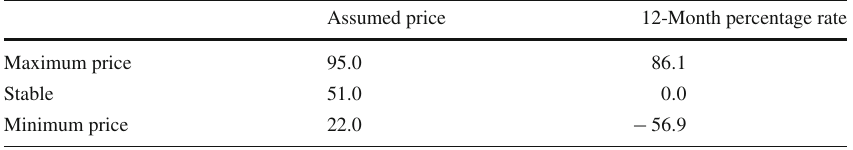
Table 6 Scenarios for Brent prices (EUR/Barrel) in